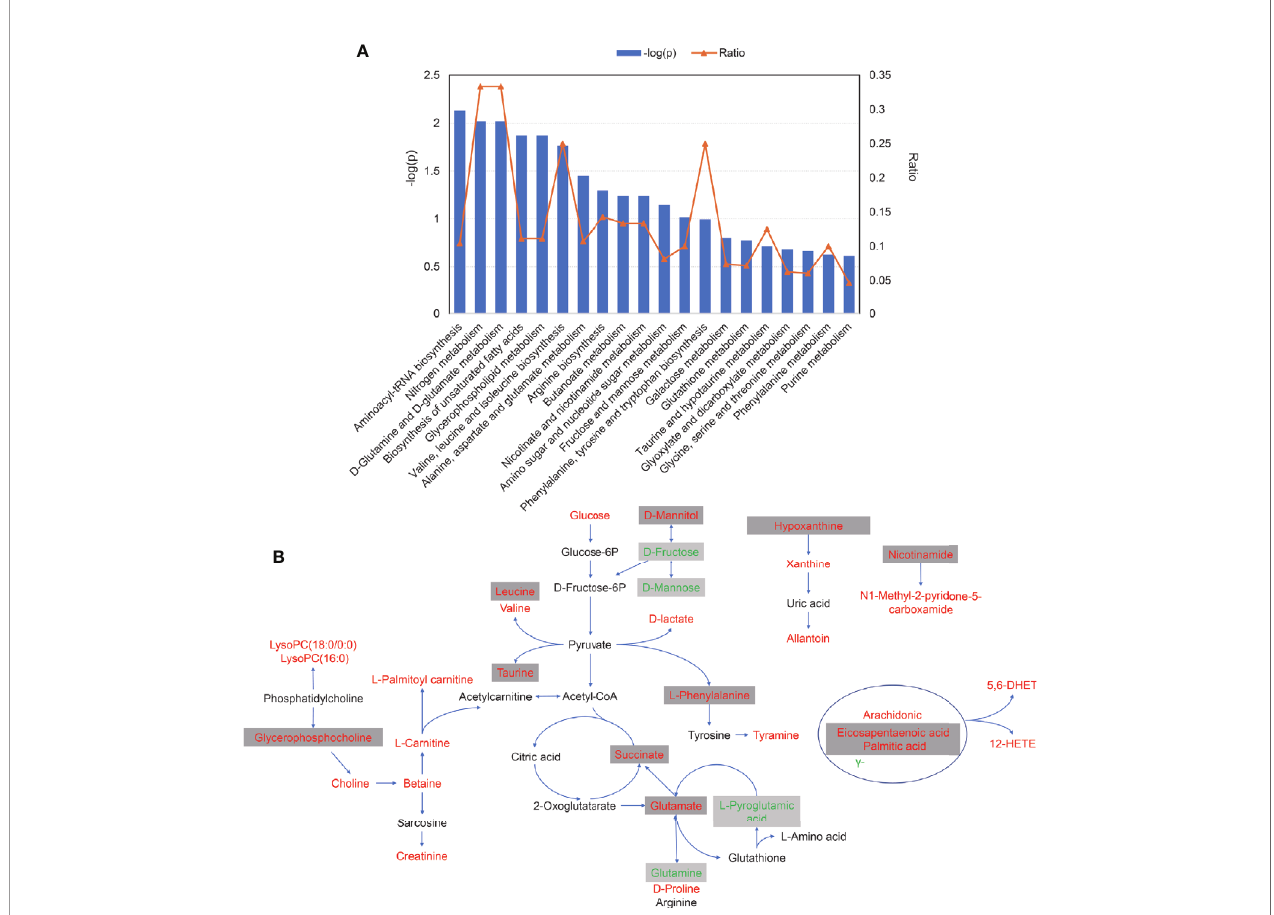
FIGURE 5 | The pathways analysis of 55 serum differential metabolites. (A) The plot of signi fi cantly disturbed pathways using MetaboAnalyst. The x-axis displays the pathways. The y-axis displays the − log of p-value calculated by hypergeometric test. The orange dots connected by a thin line represent the ratio, which is calculated as follows: the number of differential metabolites in each pathway, divided by the total number of metabolites in the pathway. (B) Schematic scheme of disturbed metabolic pathways. Metabolites marked in red, green and black indicate metabolites signi fi cantly increased, decreased, unchanged or not measured in ankylosing spondylitis patients compared with control, respectively. Metabolites in grey box represent metabolites signi fi cantly altered after TNFi